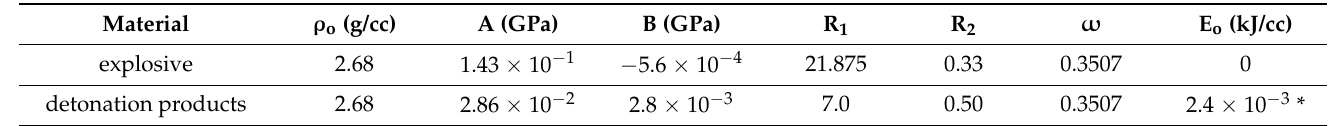
Table 2. JWL parameters assumed in the computational thermochemical code for the detonation